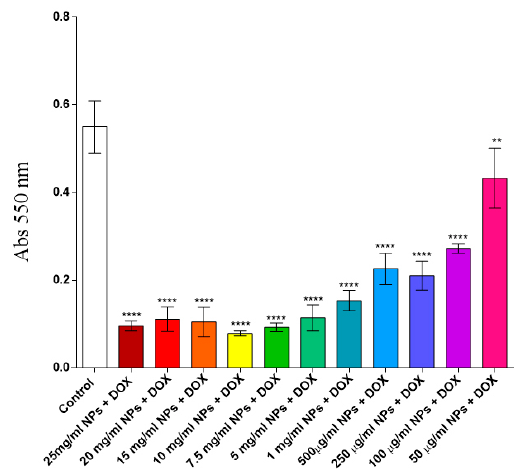
Figure 7. Graphical representation of MCF7 breast cancer cells viability after 24 h of treatment with DOX-loaded PNIPAM/magnetite NPs as shown by MTT assay (absorbance values at 550 nm); ** p < 0.01 50 microg/mL NPs + DOX vs. control; **** p < 0.0001 2 mg–100 microg/mL NPs + DOX vs. control.